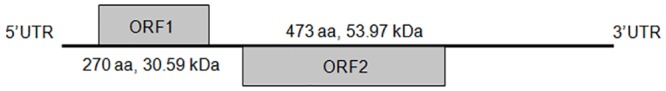
Schematic representation of the genomic organization of papaya umbraviruspapaya meleira virus 2 (PpUVPMeV2).The viral ssRNA contains two ORFs. ORF1 encodes a hypothetical protein and ORF2 encodes a putative RdRp.